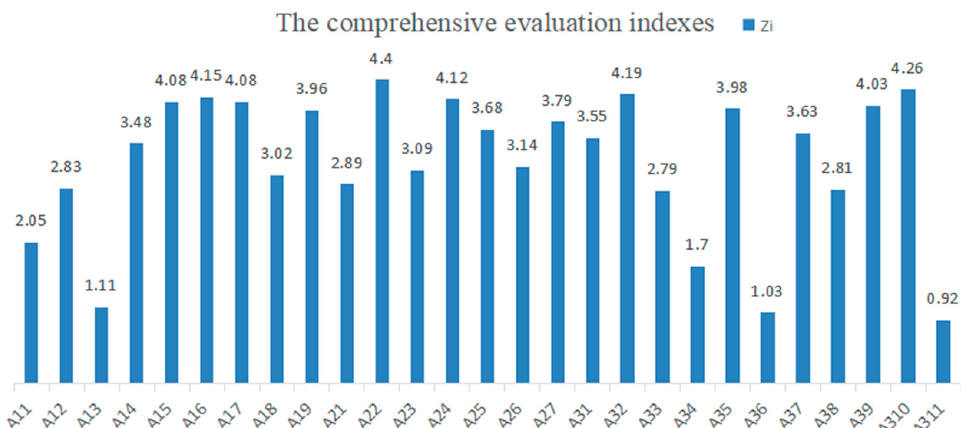
Figure 5. User satisfaction numerical coordinate distribution map.